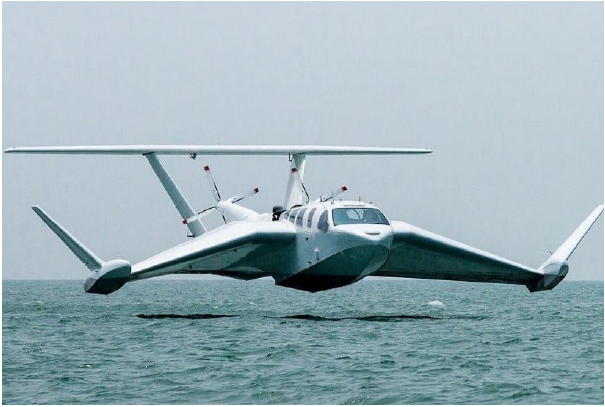
Figure 1. AirFish 8 WIG craft during cruising